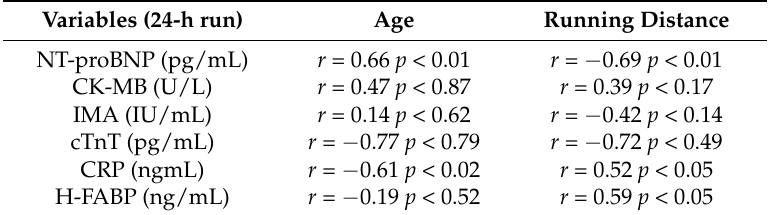
Table 4. Correlations between cardiac biomarkers age and running distance measures.